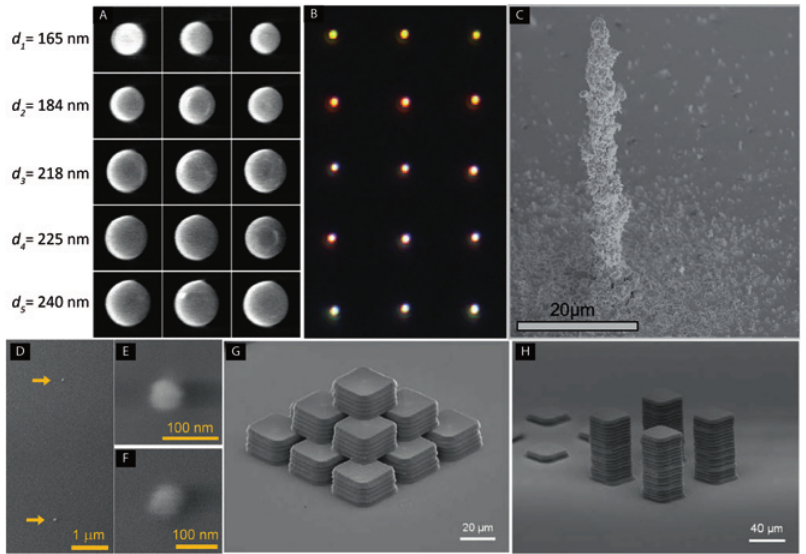
Figure 3: 2D and 3D nanofabrication using LIT. (A – B) SEM images (A) and darkfield microscopy (B) of silicon nanoparticles fabricated with LIBT using different laser